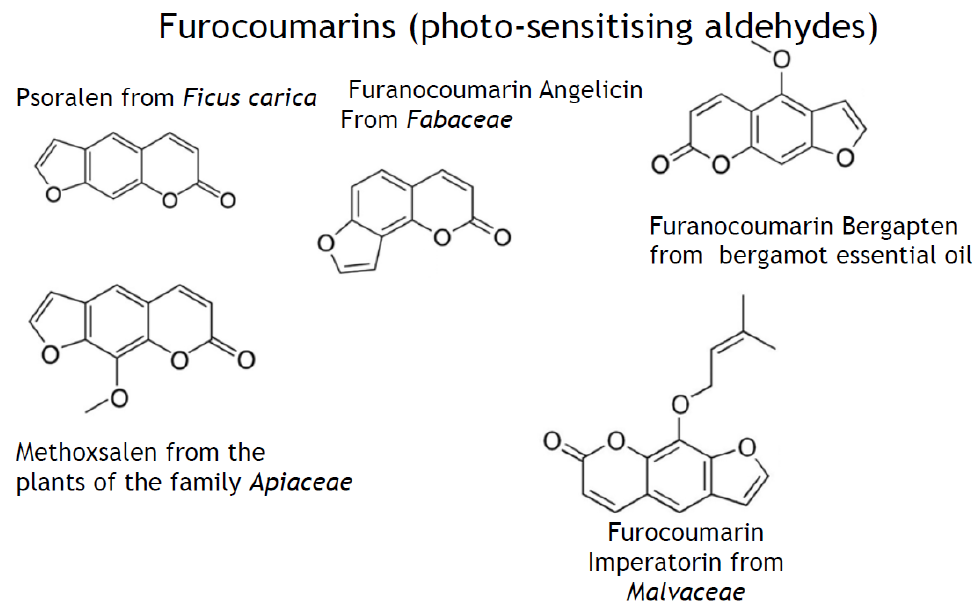
Figure 5. Polyaromatic secondary plant metabolites with aldehyde group(s) are mainly photo-sensitisers. Examples of polyaromatic aldehyde-containing secondary plant metabolites with prevalently photo-sensitising properties.